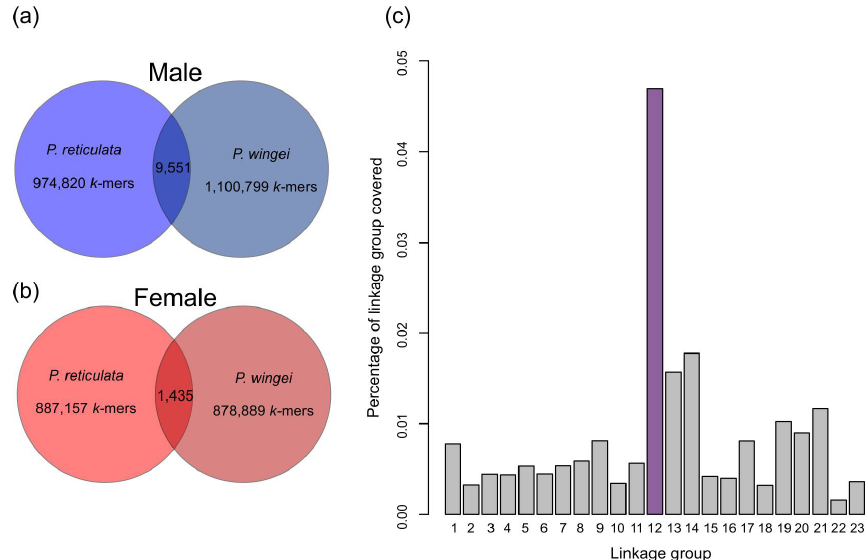
Figure 1. ( a ) Male-specific k -mer counts above 30× coverage in Poecilia reticulata and P. wingei and shared across both; ( b ) female-specific k -mer counts above 30× coverage in P. reticulata and P. wingei and shared across both; ( c ) homology of assembled Y-linked contigs to each linkage group in the P. reticulata genome, showing the percentage of each linkage group covered by contigs ((bp length of contigs/bp length of linkage group) × 100).